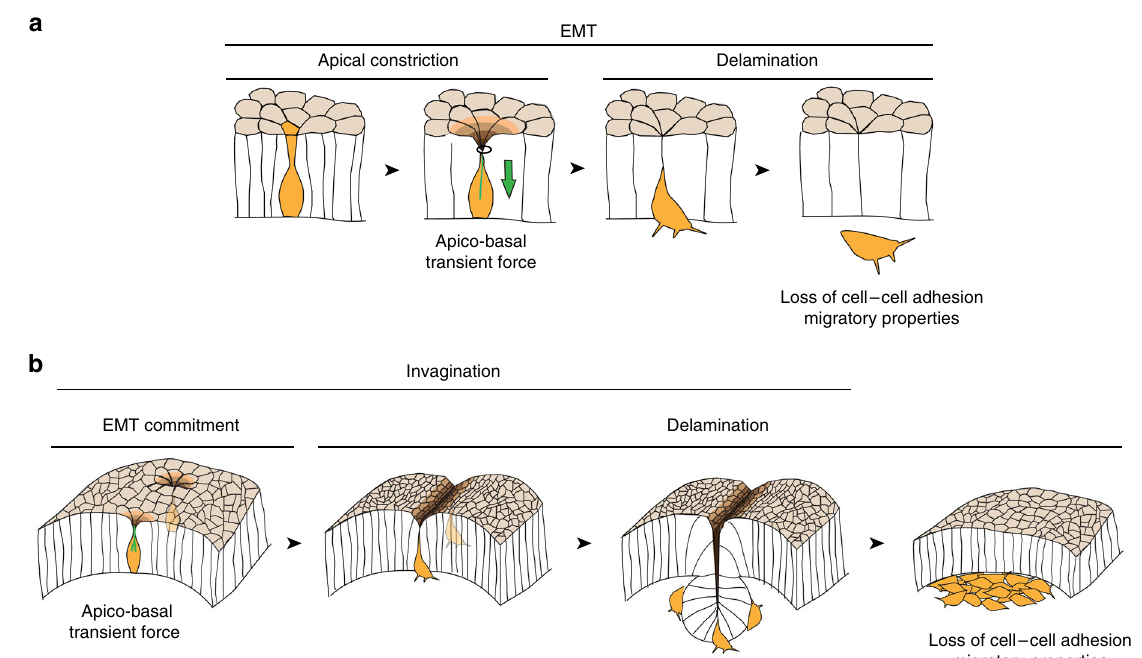
Fig. 10 Schemes recapitulating our working model on EMT induced folding. a Schemes of the successive steps of EMT including apical constriction, generation of an apico-basal pulling force (green arrow) leading to apical deformation, and delamination. b Schemes of fold formation driven by the delamination of cells entering EMT. Two cells (yellow) pull transiently on the apical surface of the epithelium, then neighboring cells constrict their apices in this region of the tissue and a fold is formed (depth is color-coded) while cells start to delaminate sporadically, then